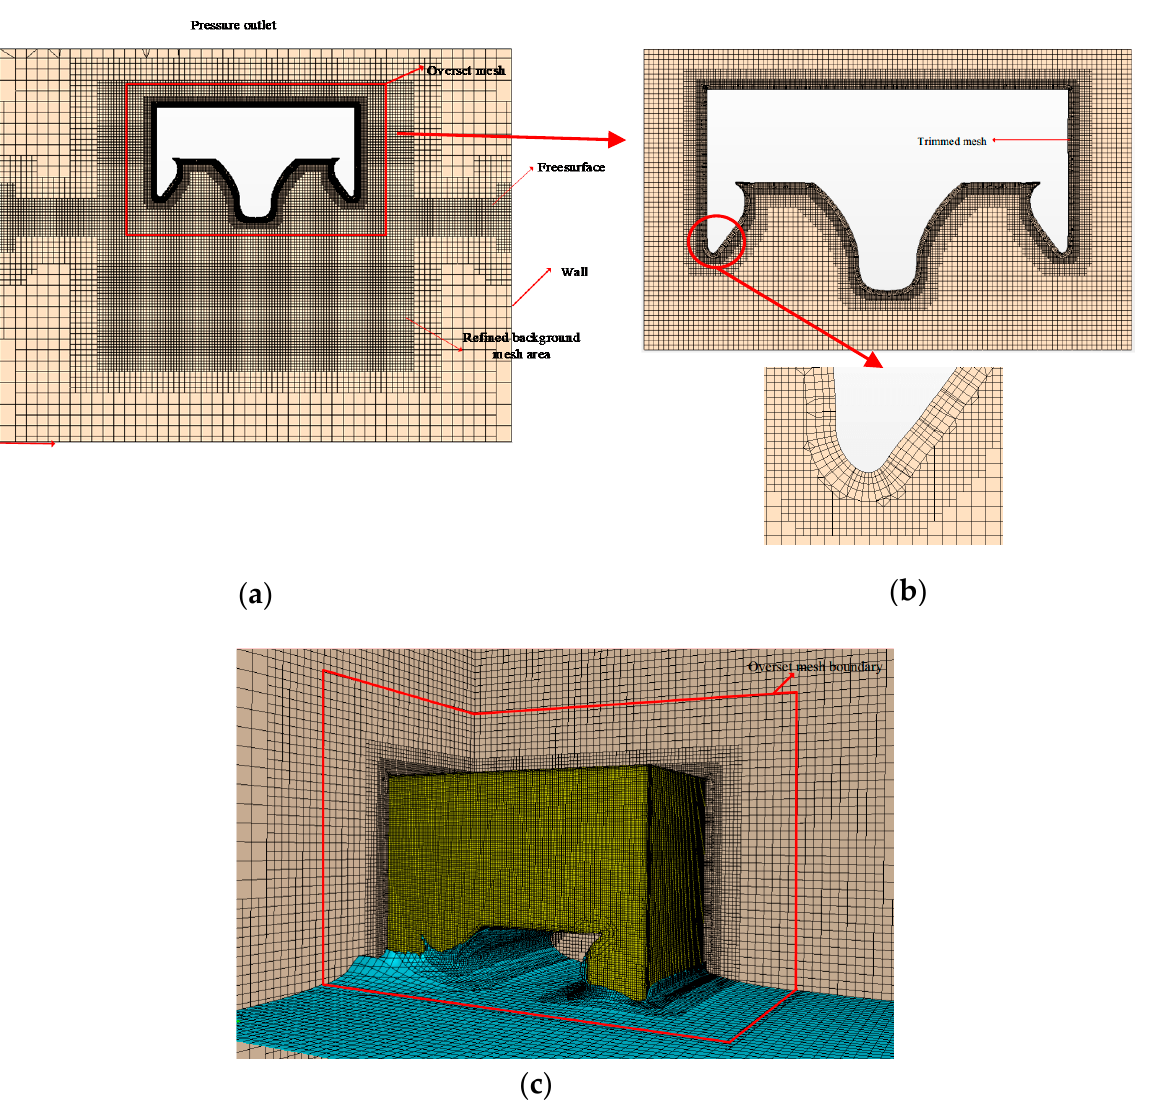
Figure 2. Mesh distribution and the boundary condition setting used in simulation (( a ) Meshes of middle section; ( b ) Overset mesh area and enlarged trimmed mesh around the side hull corner; ( c ) Body surface and free surface mesh).